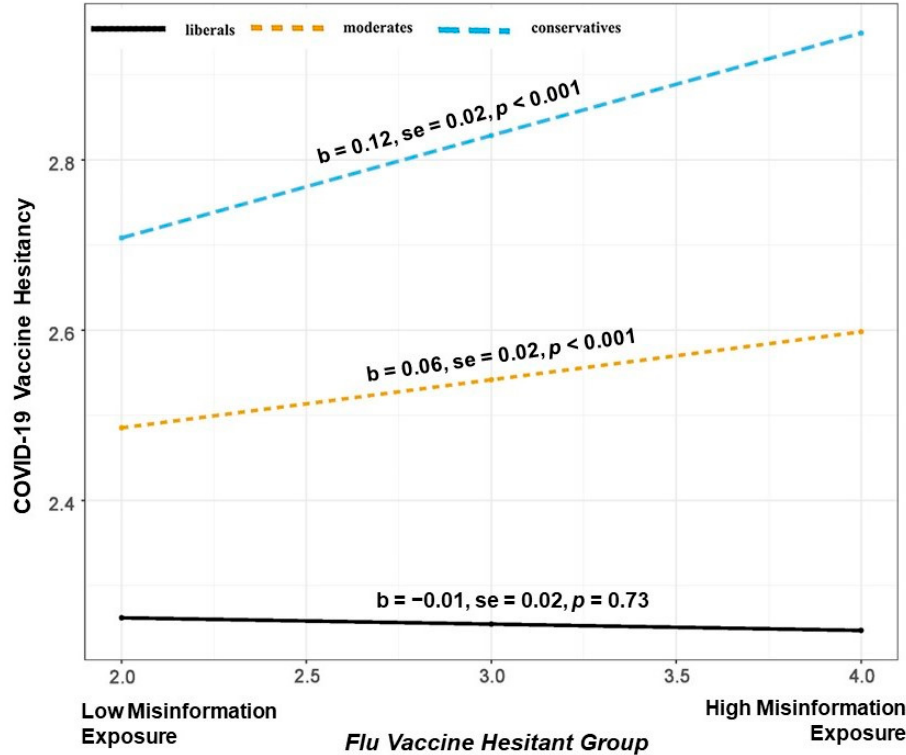
Figure 2. Illustration of the interaction between perceived misinformation exposure and political ideology in predicting COVID-19 vaccine hesitancy for the flu vaccine hesitant group.